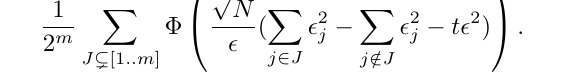
Algorithm 1MT. For a wrong key β of type J , the probability that β is a false alarm